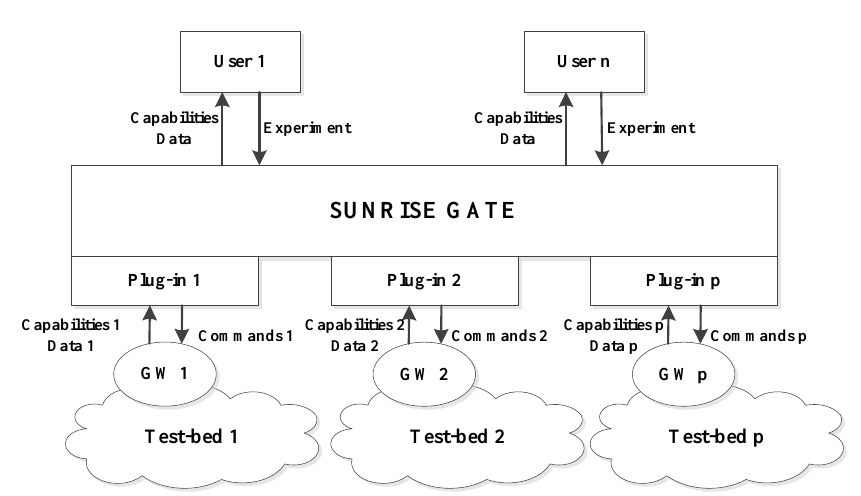
Figure 10. Conceptual schema of the SUNRISE federation architecture, as described in [43].